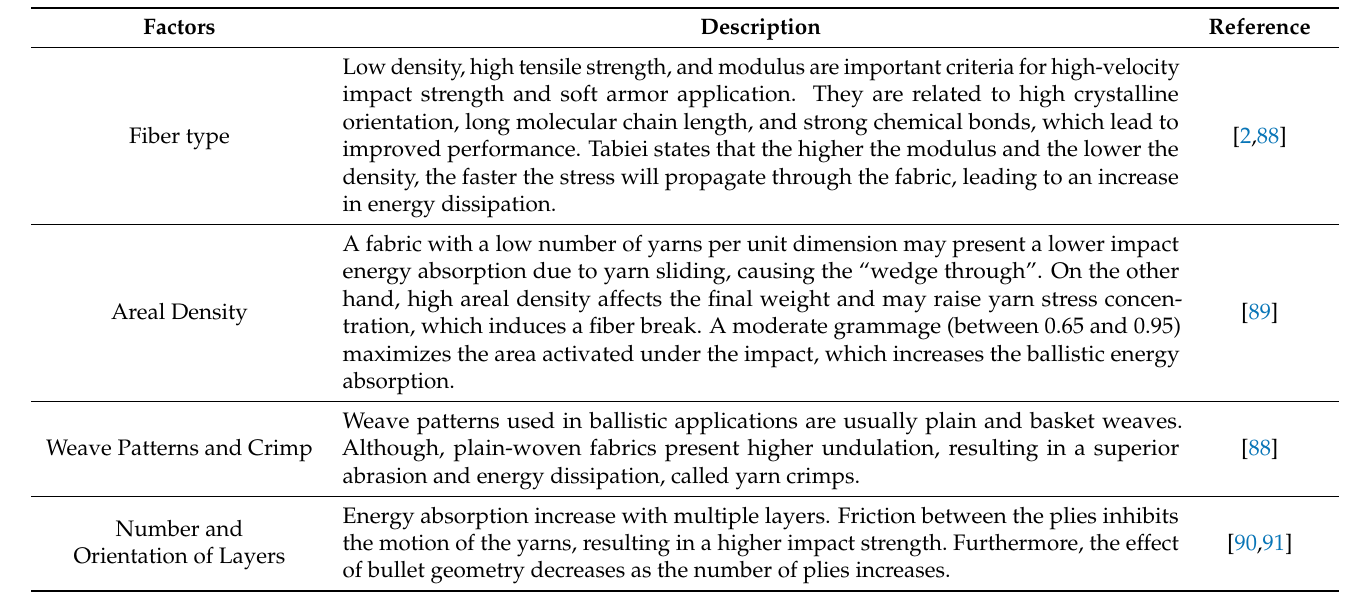
Table 4. Summary of factors influencing the ballistic performance of ballistic